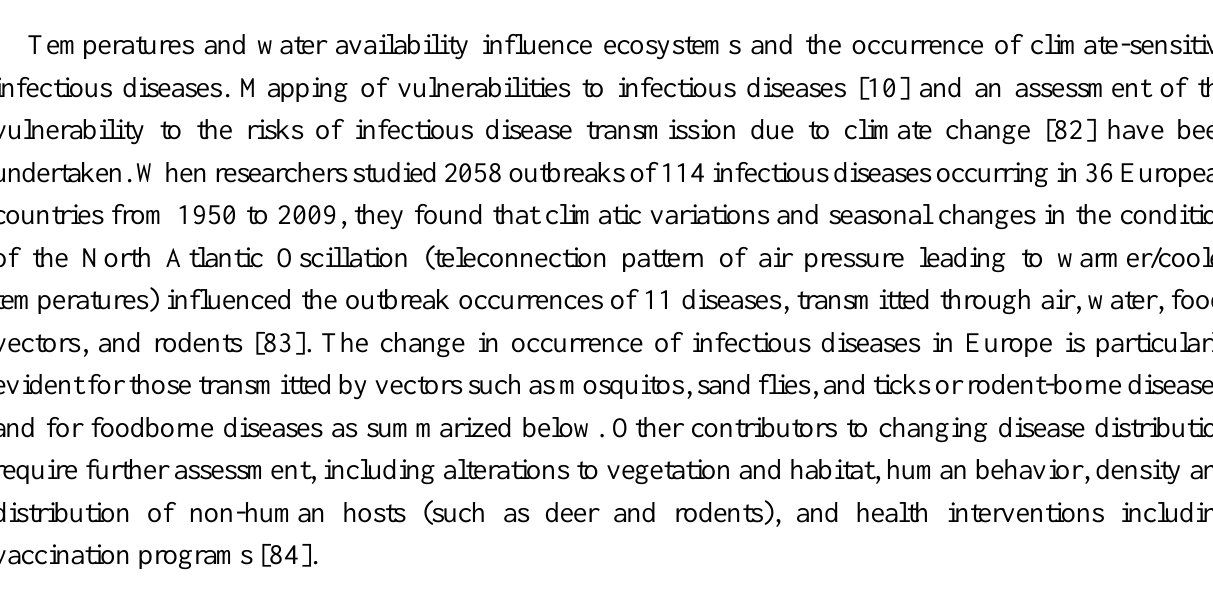
Table 6. Search results about the health effects of UV radiation